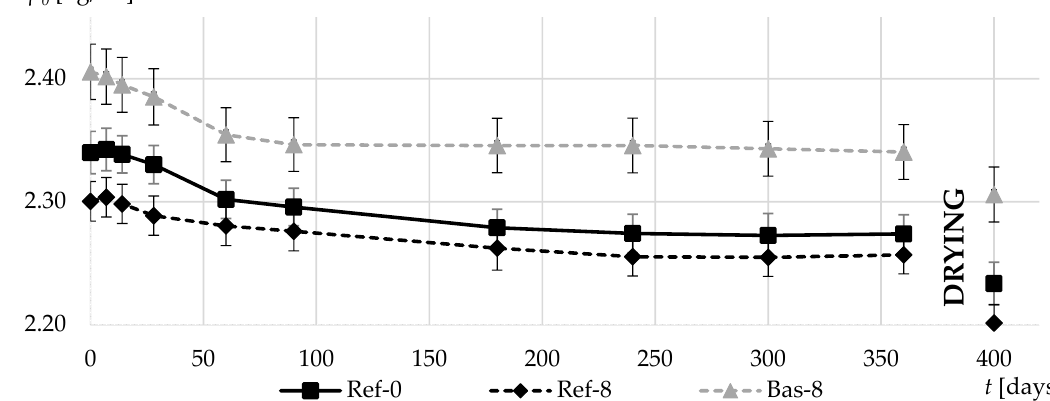
Figure 8. Specific gravities in the first 360 days of composites curing and after additional drying.